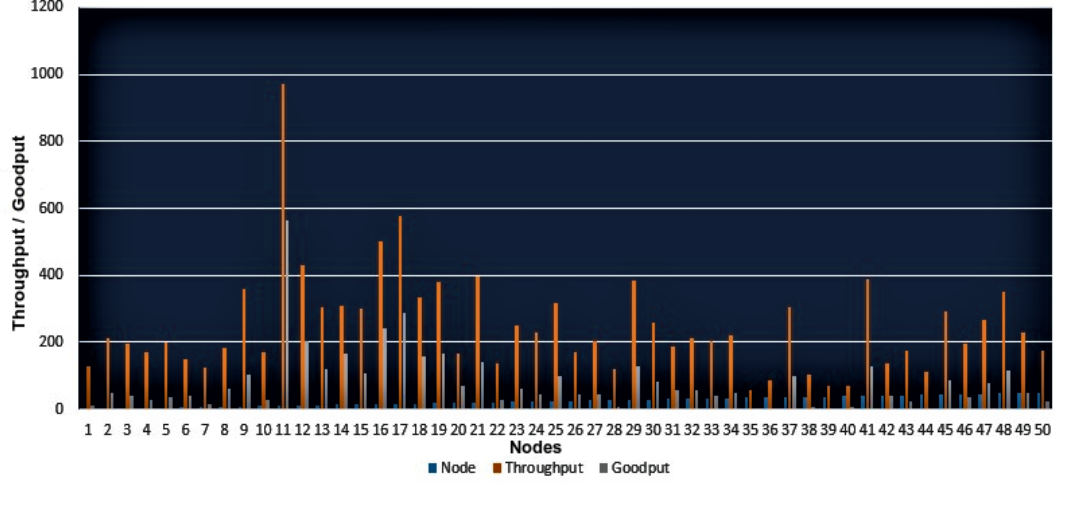
Figure 15. Throughput and